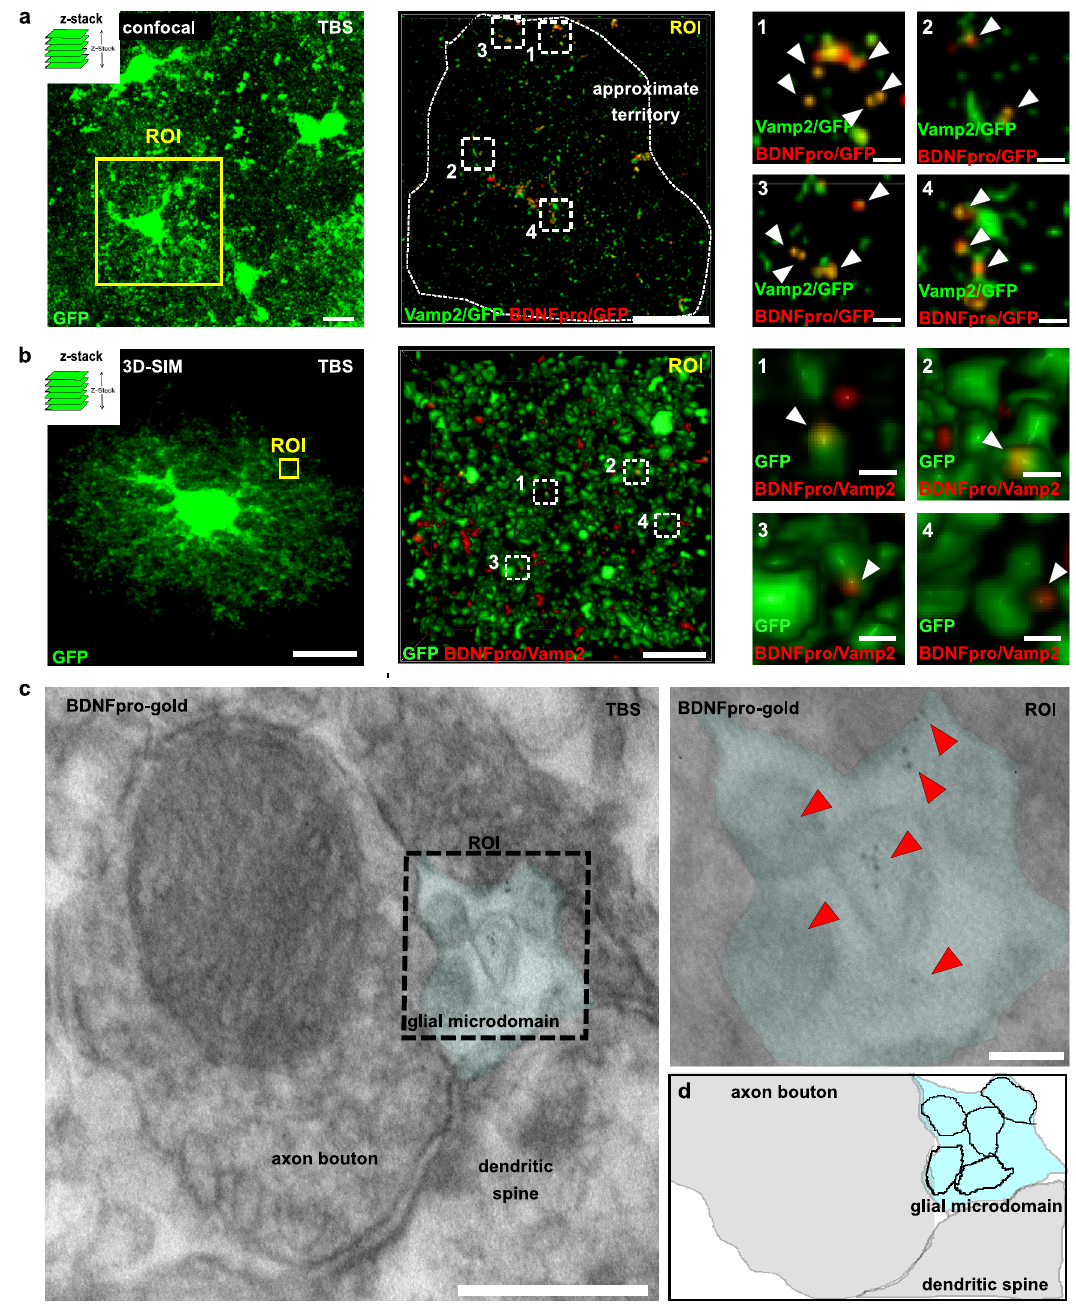
Fig. 4 vesicular localization of BDNFpro. a z-stack reconstruction shows astrocytes labeled by GFP. Cortical slices from control mice injected with AAV- GFAP-GFP virus were fi xed 10 min after TBS and processed for immunostaining and confocal analysis. Scale bar: 10 µ m. Magni fi cation of a ROI shows one GFP-astrocyte delimited by an approximate territory (white dashed). Scale bar: 10 µ m. BDNFpro/GFP and Vamp2/GFP co-localizations signals are shown. Magni fi cation shows representative areas (dashed squares 1 to 4) in which BDNFpro/GFP and Vamp2/GFP signals overlap. Scale bars: 1 µ m. b 3D-SIM image of a GFP-labeled astrocyte in a TBS-slice from control mice. Scale bar: 10 µ m. Magni fi cation of a ROI shows BDNFpro/Vamp2 colocalization signal. Scale bar: 500 nm. Magni fi cation shows BDNFpro/Vamp2 colocalization signal in fi ne membrane extensions of the cell periphery (dashed squares 1 to 4). Scale bars: 50 nm. c EM image depicts BDNFpro-gold at astrocytic microdomains (light blue) surrounding an axon bouton. Scale bar: 100 nm. Magni fi cation of the ROI shows gold particles (red arrowheads) in vesicular-like structures. Scale bar: 20 nm. d Digital reconstruction of the image in ( c ). Astrocytic vesicles (black boundary) are